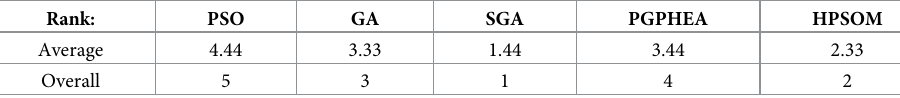
Table 14. Discrete problem algorithm ranking.